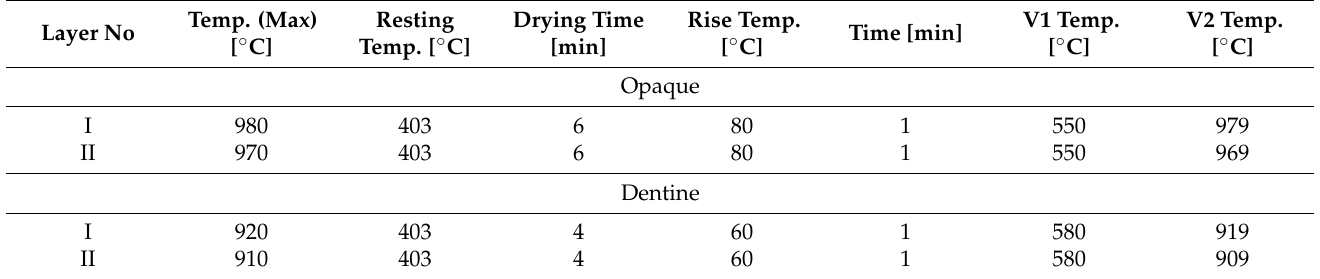
Table 3. The parameters of ceramic firing. V1—vacuum start temperature, V2—vacuum end temper-